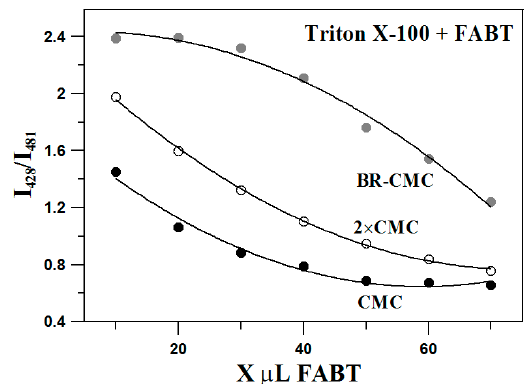
Figure 4. Correlations between the intensity of fluorescence at the wavelength of 428 to 481 nm and changes in the amount of FABT added analogously to Figure 3. Points of measurement were matched with polynomial curves. Molecules 2018 , 23 , x FOR PEER REVIEW